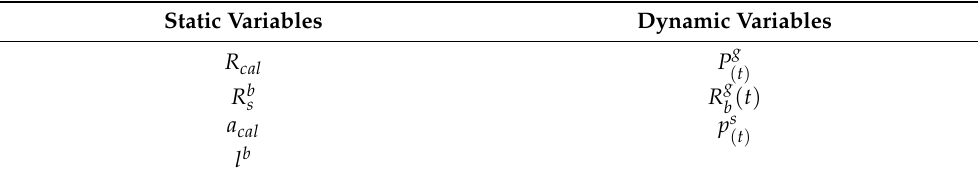
Table 3. Static and dynamic variables of the georeferencing equation.